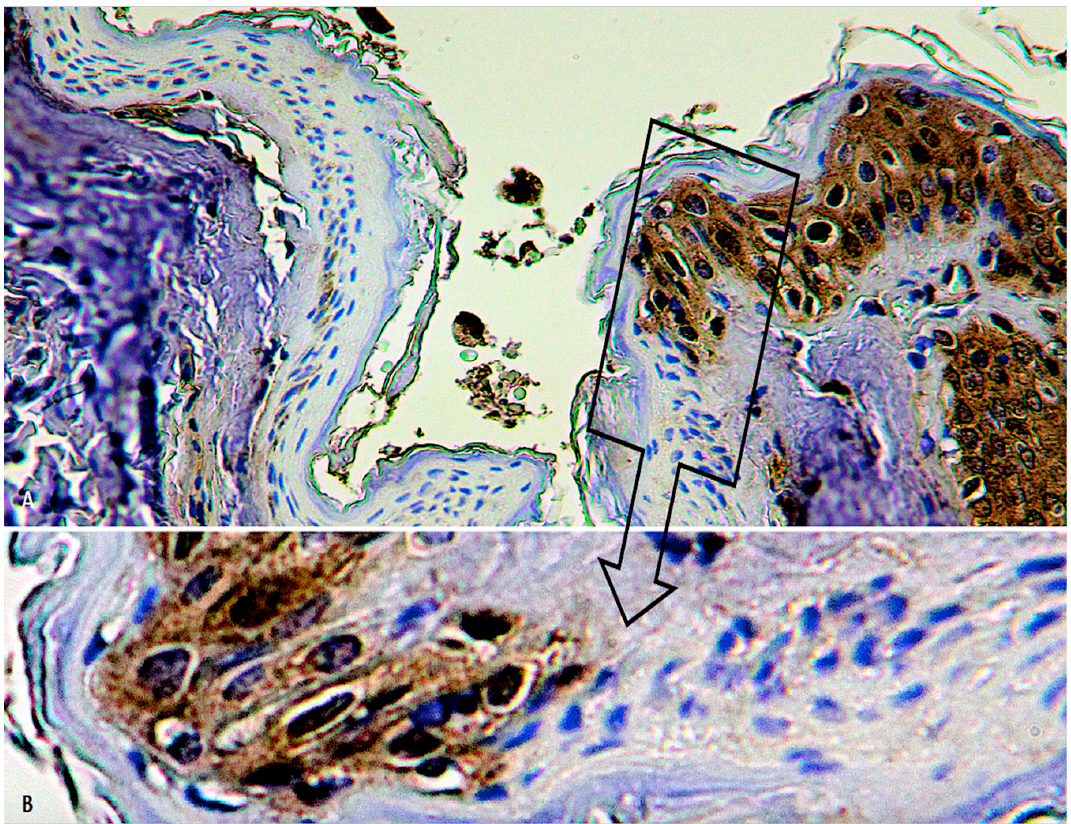
Figure 4. ( A ) No substantial differences in the intracytoplasmic depletion of FLIP in the epidermal layers in relation to the type of hanging (incomplete in this case) or material used (bed sheet) (x300). ( B ) Insert of ( A ) at higher magnification (×500).